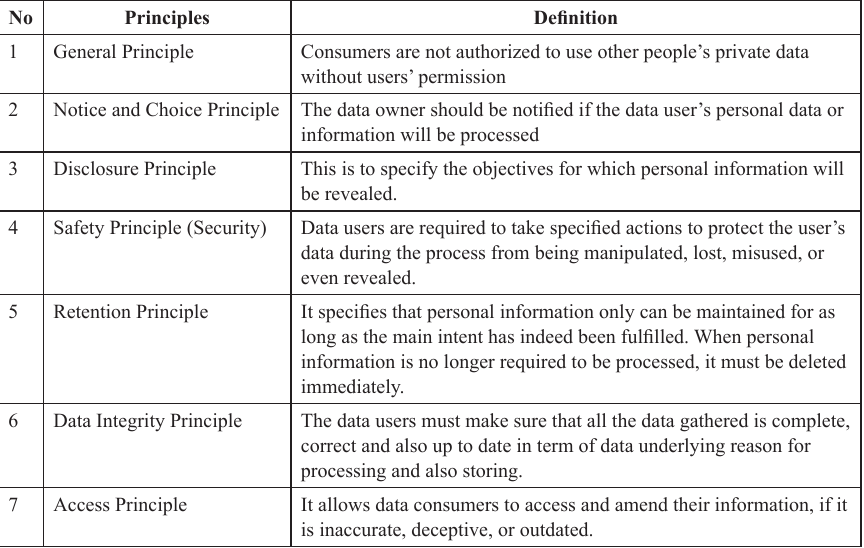
Table 1. Principles of personal